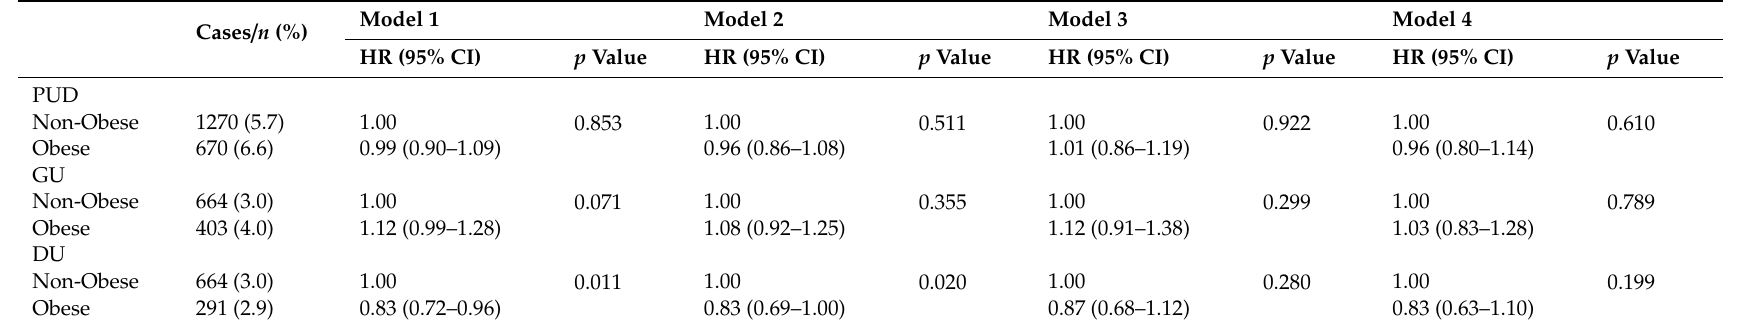
Table 2. Association between obesity and the risk of peptic ulcer